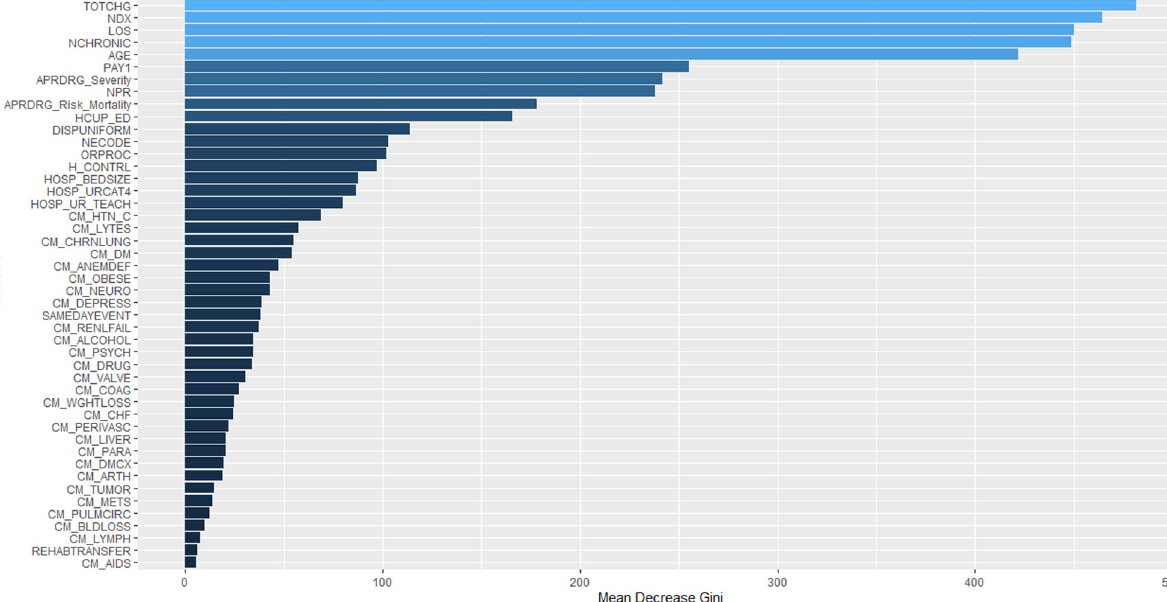
Fig. 3 Important feature selection by using random forest. Blue bars show the mean decreased Gini index for 46 predictor candidates.